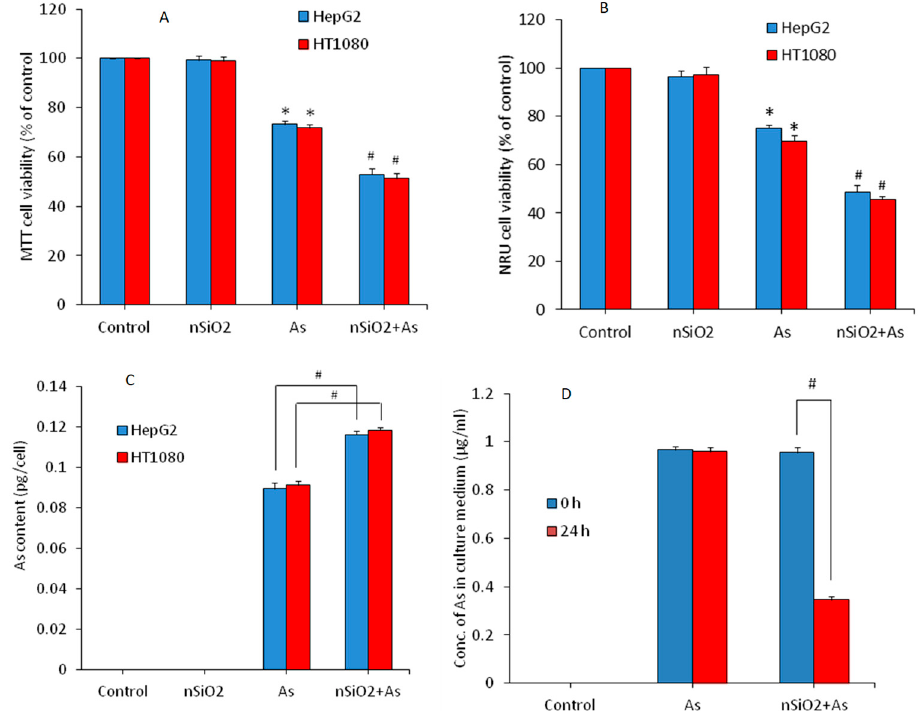
Figure 2. Cytotoxicity of HepG2 and HT1080 cells exposed for 24 h to silica nanoparticles (nSiO 2 ) (10 μ g/mL), As (1 μ g/mL) or SiO 2 + As (10 μ g/mL + 1 μ g/mL). ( A ) 3-(4, 5-dimethylthiazol-2-yl)-2, 5-diphenyltetrazoliumbromide (MTT) assay. ( B ) Neutral red uptake (NRU) assay. ( C ) Intracellular level of As in HepG2 and HT1080 cells exposed to nSiO 2 (10 μ g/mL), As (1 μ g/mL) or SiO 2 + As (10 μ g/mL + 1 μ g/mL) for 24 h. ( D ) Adsorption of As on the surface of nSiO 2 in culture medium. Data are presented as the mean ± SD of three independent experiments (n = 3). * indicates significant effect in comparison to the control group ( p < 0.05). # indicates significant effect in comparison to nSiO 2 group alone or As group alone (p < 0.05).